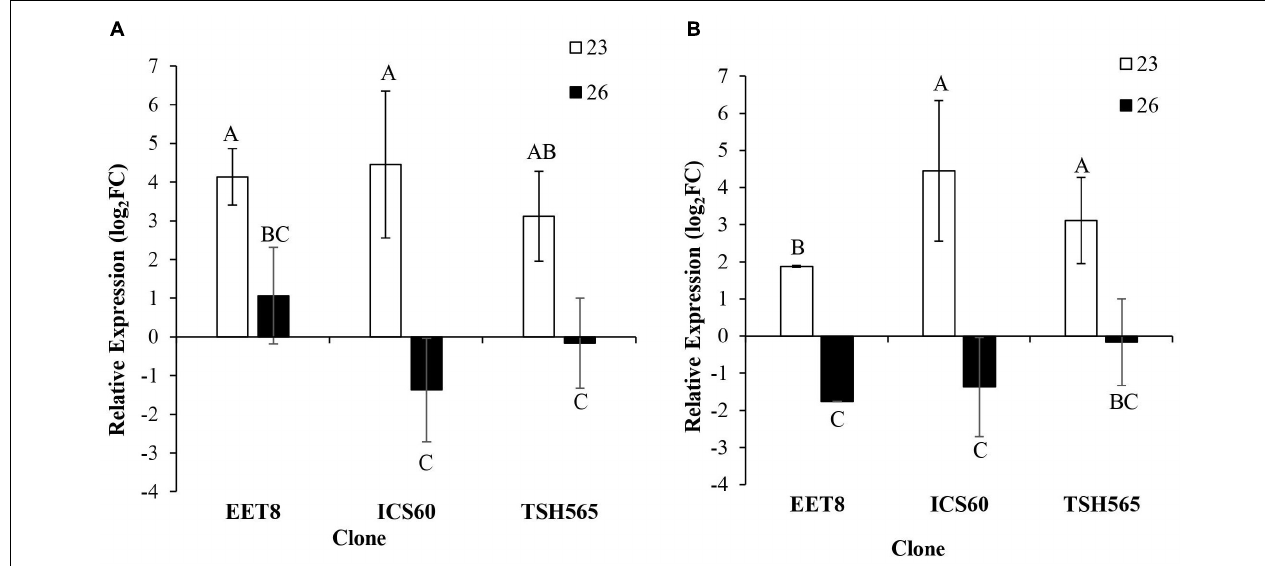
FIGURE 2 | Effect of water deficit on the transcriptional expression of oxidative stress markers. (A) GST . (B) Hsp17.6 . Bars represent the averages of the induction factor (log2-fold change) ± standard deviation ( n = 3) relative to the control (day 0). The letters indicate statistically significant differences between days 23 and 26 of water deficit ( P <